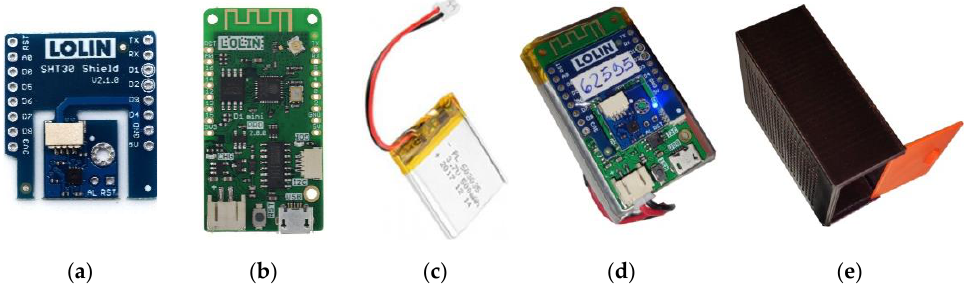
Figure 1. Sensing module components: LOLIN SHT30 v2.1.0 shield ( a ), LOLIN D1 mini pro V2.0 microcontroller ( b ), 3.7 V 500 mAh lithium battery ( c ), assembled sensing module ( d ) and 3D-printed case ( e ).